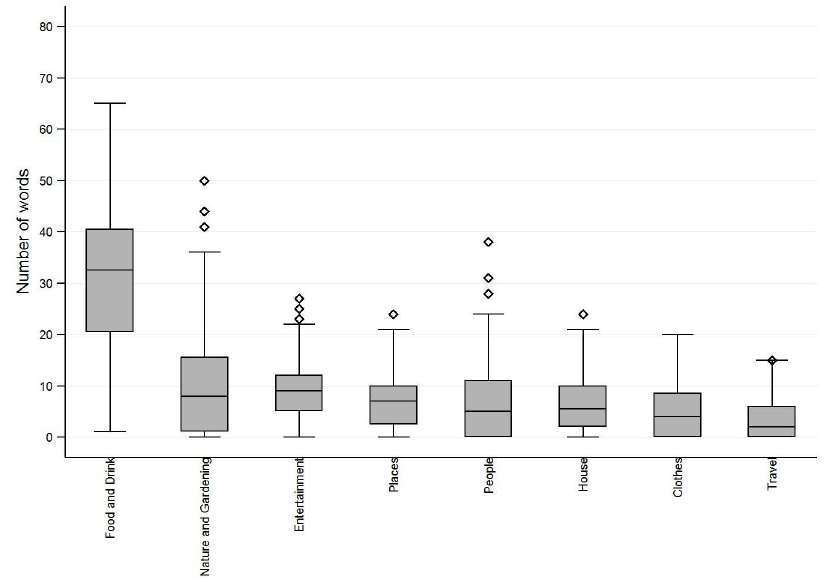
Fig 1. Distribution of words chosen across participants by